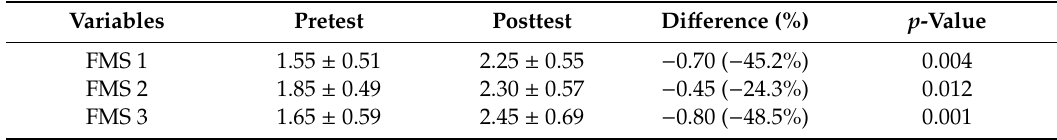
Table 4. Results of the functional status assessment of the functional status of the tested group of players (n = 20). The significance of di ff erences was assessed using the Wilcoxon test.